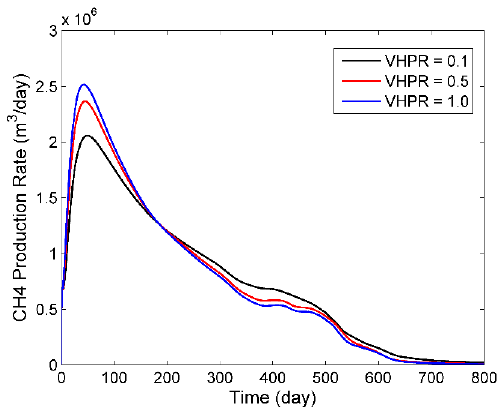
Figure 29. CH 4 production rates with various vertical-horizontal permeability